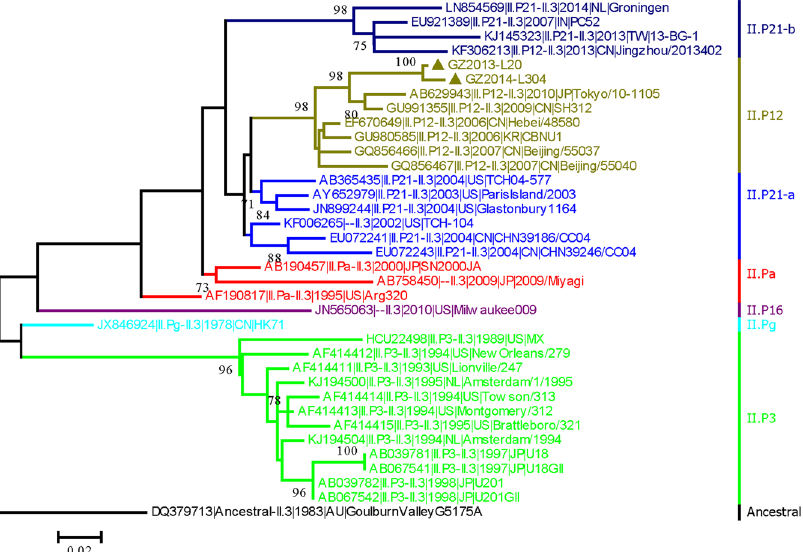
Figure 4. Phylogenetic tree of ORF2-GII.3 recombinants based on nucleotide sequences of VP2 encoding region. The maximum likelihood tree was constructed using PhyML 3.0 with the general time-reversible (GTR) substitution model by jmodeltest 2 program. Numbers at the nodes indicate supporting bootstrap values (%) for 1000 resampled datasets, and only values greater than 70% are shown. The scale bar represents the unit for the expected number of substitutions per site. Guangzhou NoV strains are designated by location, year, and identification number (indicated by the black diamond). Reference sequences are indicated by their accession numbers, genotypes, years, countries, and strain